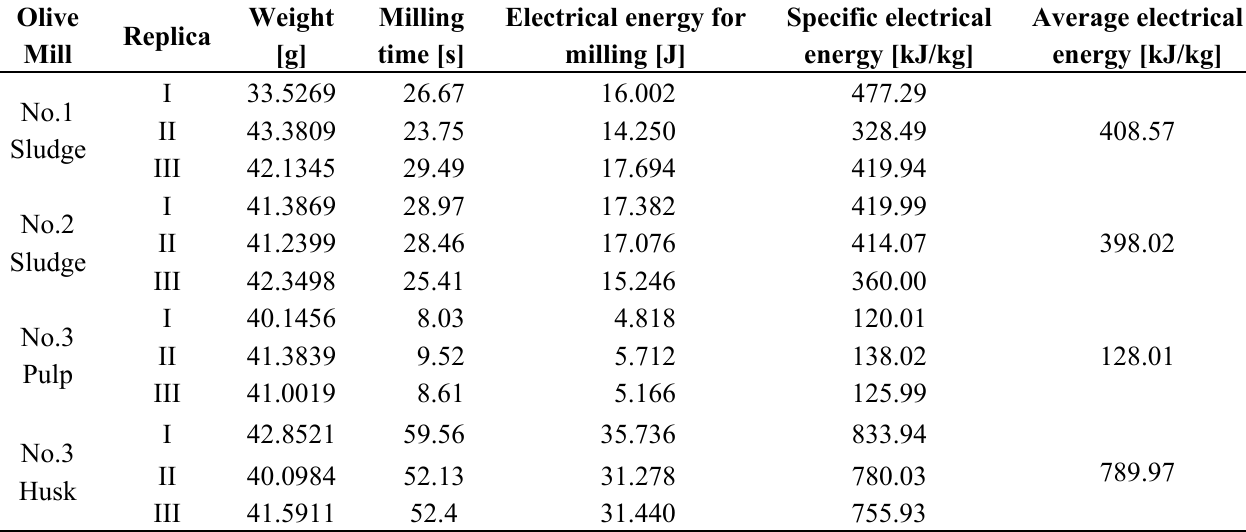
Table 3. Milling energy consumption.